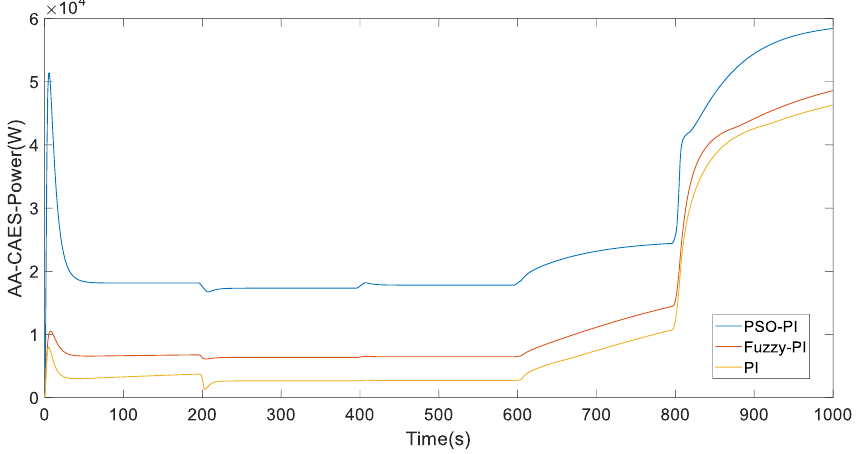
Figure 18. AA-CAES output power in Example 1.